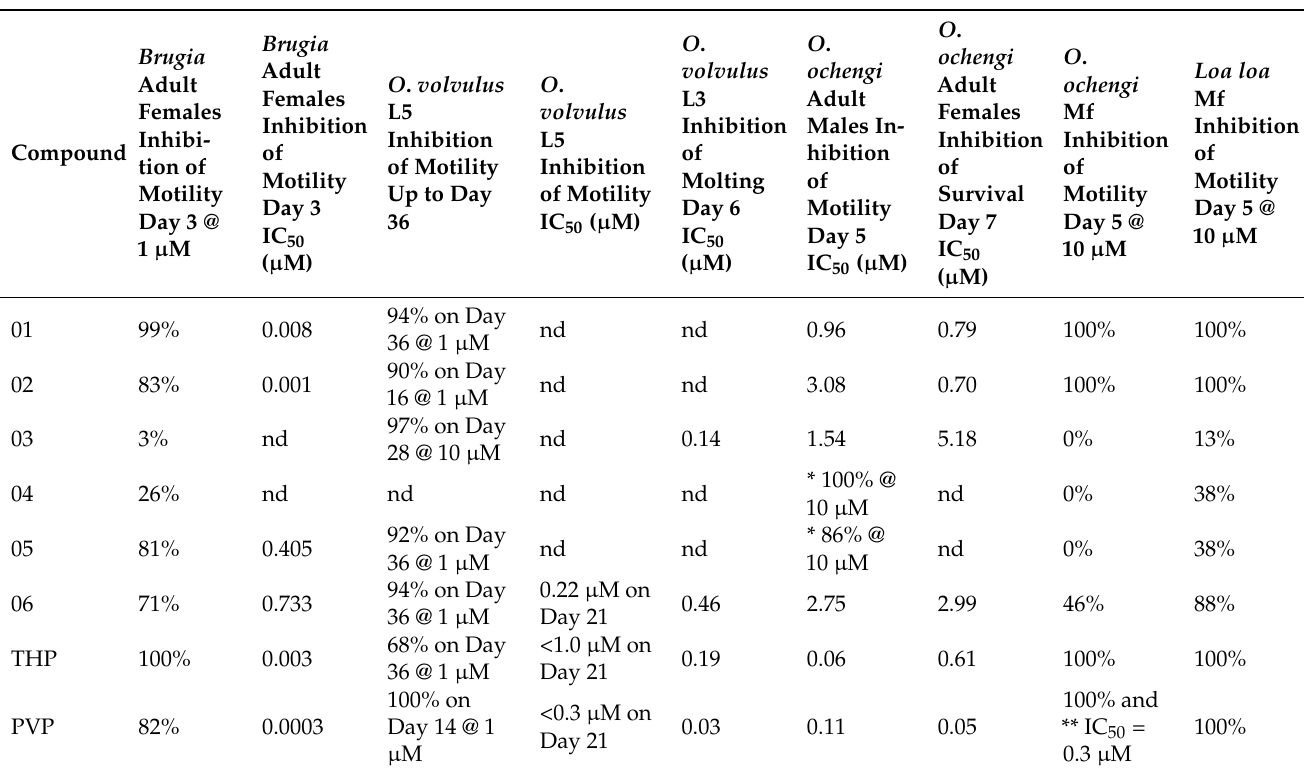
Table 1. Results of the in vitro whole-worm